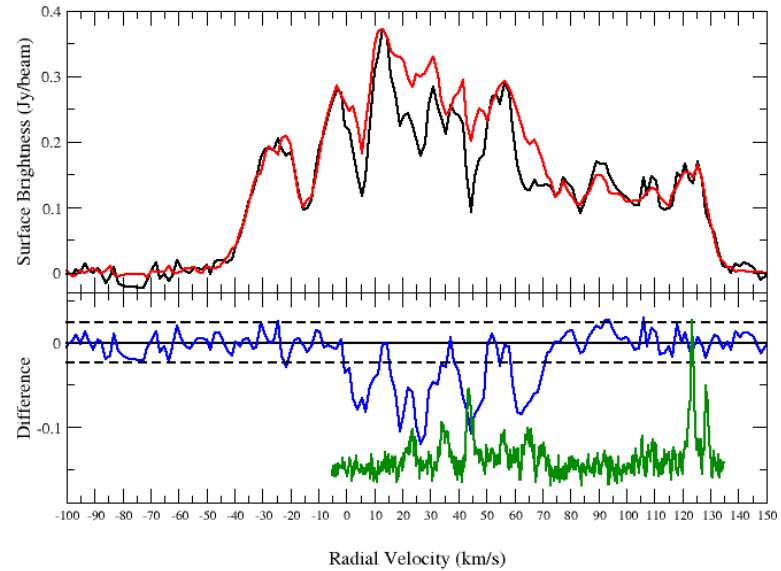
Figure 4. HI spectrum of the SNR candidate G18.760-0.072. Top panel: HI emission spectra (source: black and background: red). Bottom panel: source—background (blue). The dashed lines are ± 2 σ noise level of the difference. The green curve in the lower panel is the 13 CO emission